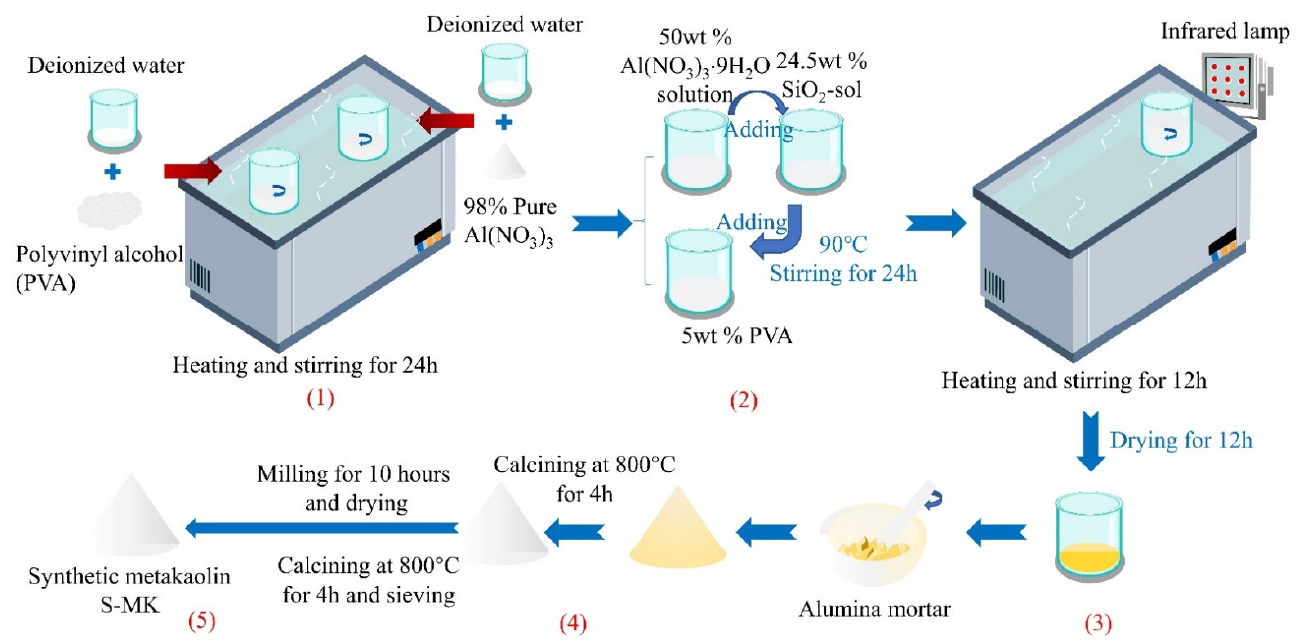
Figure 1. The schematic diagram of fabrication process for the synthetic metakaolin, using the polymeric steric entrapment precursor route.